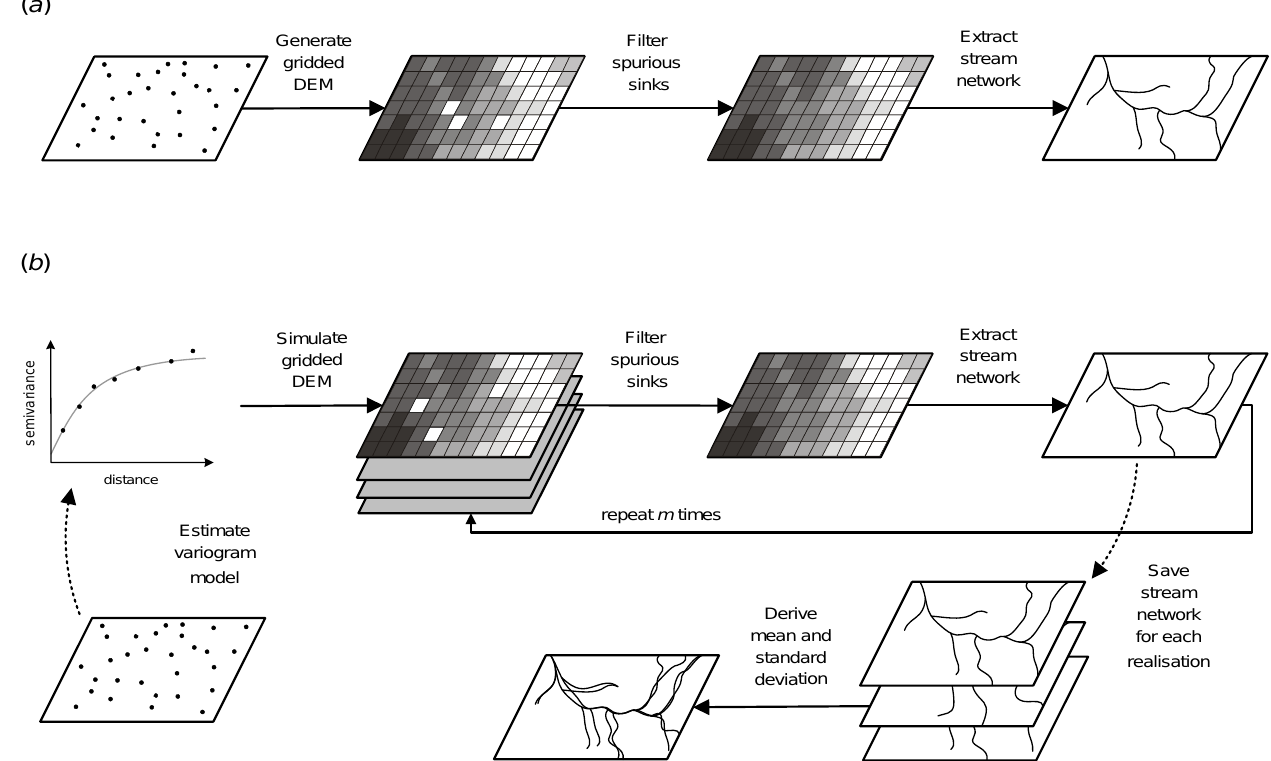
Fig. 1. Workflow scheme for stream extraction from elevation data: (a) assuming that elevations carry no uncertainty; (b) the Monte Carlo error propagation approach with m realizations. In this case, filtering of spurious sinks is specific to the case studies and not a general